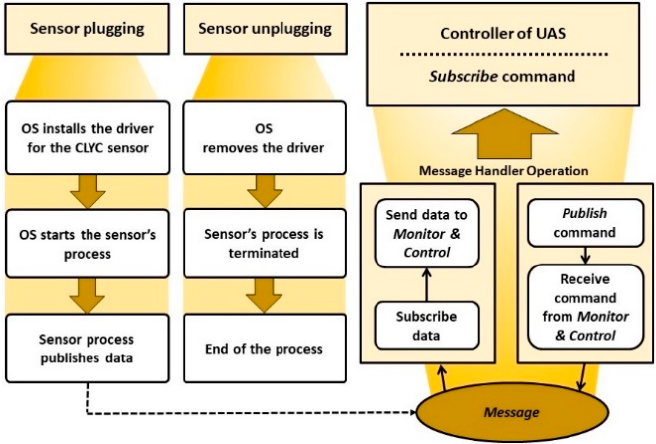
Figure 4. ( a ) Scheme of CLYC sensor operation; ( b ) sensor package.